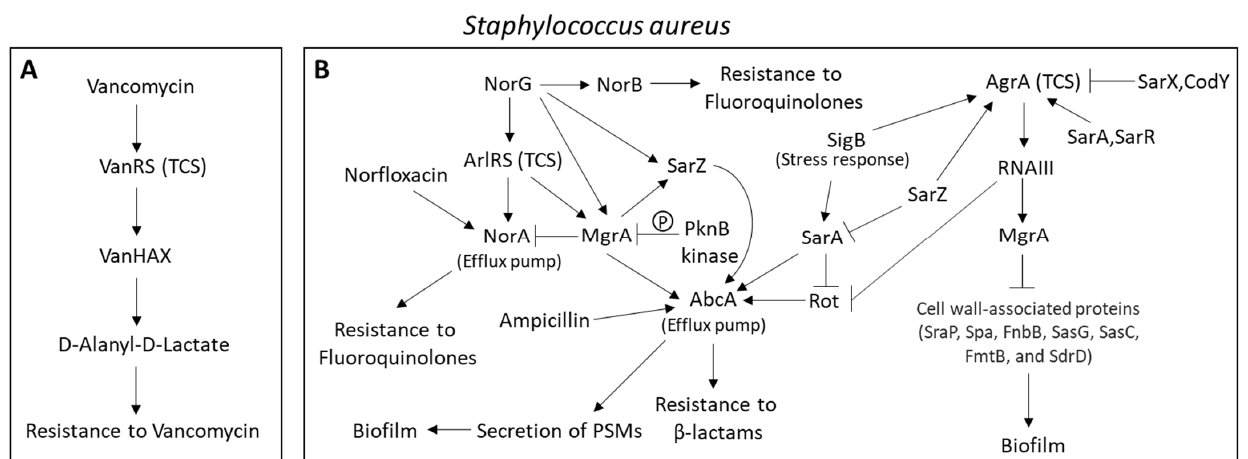
Figure 1. ( A ). Induction of vancomycin resistance in Staphylococcus aureus by vancomycin . Vancomycin activates the TCS VanRS, which induces the expression of the vanHAX operon responsible for the synthesis of the D-alanyl-D-lactate dipeptide. The D-alanyl–D-lactate dipeptide shows a 1000-fold lower affinity to vancomycin compared to the regular D-alanyl–D-alanine dipeptide, thereby conferring vancomycin resistance. ( B ). Examples of regulatory mechanisms involved in antibiotic resistance and biofilm formation in Staphylococcus aureus . The expressions of the efflux pumps NorA and AbcA, which confer antibiotic resistance to fluoroquinolones and β -lactams, respectively, are induced by their respective substrates norfloxacin and ampicillin. Additionally, their expression levels are influenced by the ArlRS and Agr TCSs, which both affect the global transcriptional regulator MgrA (also known as NorR). Phosphorylation of MgrA by the PknB serine/theonine kinase leads to increased transcription of norA . The ArlRS and Agr TCSs are regulated by several transcriptional factors (e.g., NorG, Rot, SarA, SarR, SarZ, SigB) as illustrated in the figure. This network of regulatory factors also affects biofilm formation, where AbcA promotes biofilm formation by exporting phenol- soluble modulins (PSMs), and the Agr QS prevents biofilm formation. The Agr QS is explained in more detail in Section